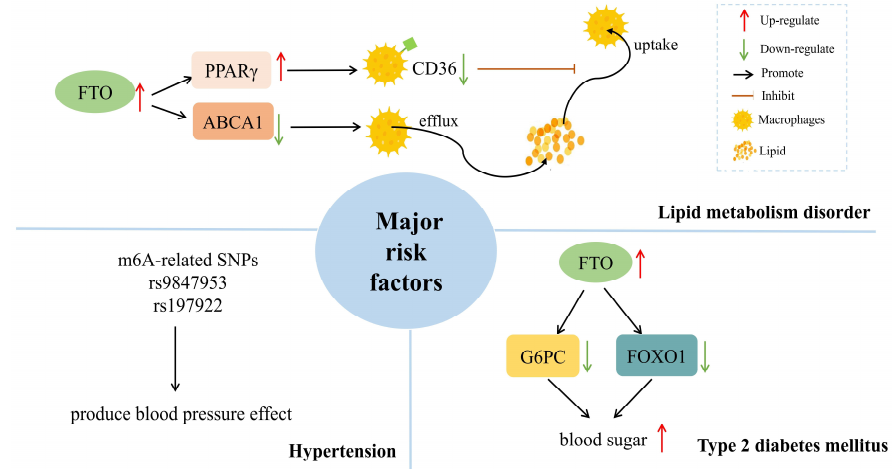
Figure 2. Effects of m6A methylation on the development of AS major risk factors. PPARγ, prolifer- ator-activated receptor γ; SNPs, single nucleotide polymorphisms; G6PC, glucose-6-phosphatase catalytic subunit; FOXO1; forkhead box protein O1.